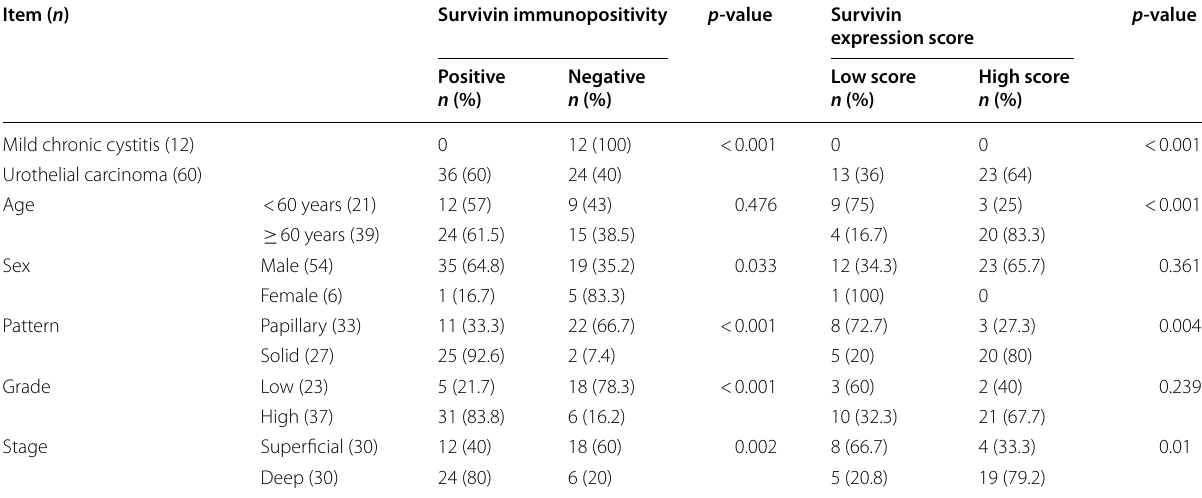
NMIBC Non-muscle invasive bladder cancer, MIBC Muscle-invasive bladder cancer, n Number, %